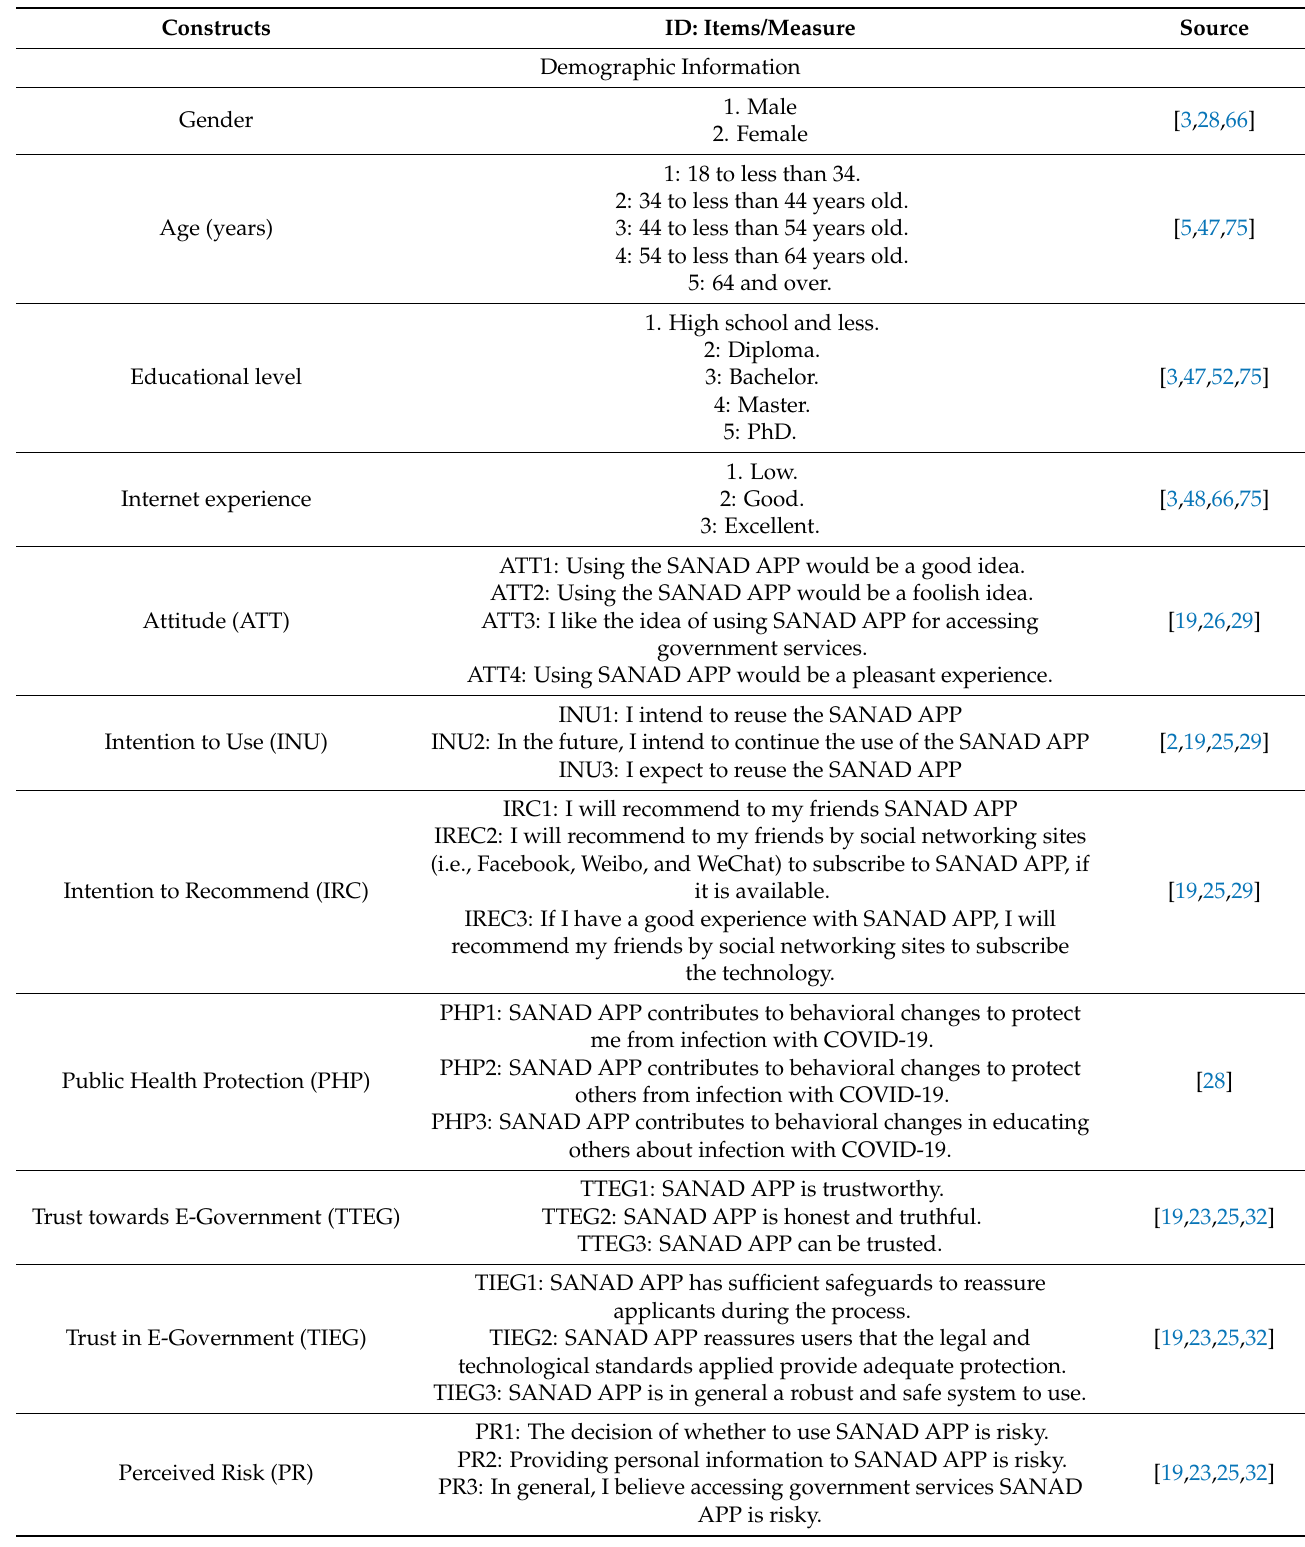
Table A1. Constructs and